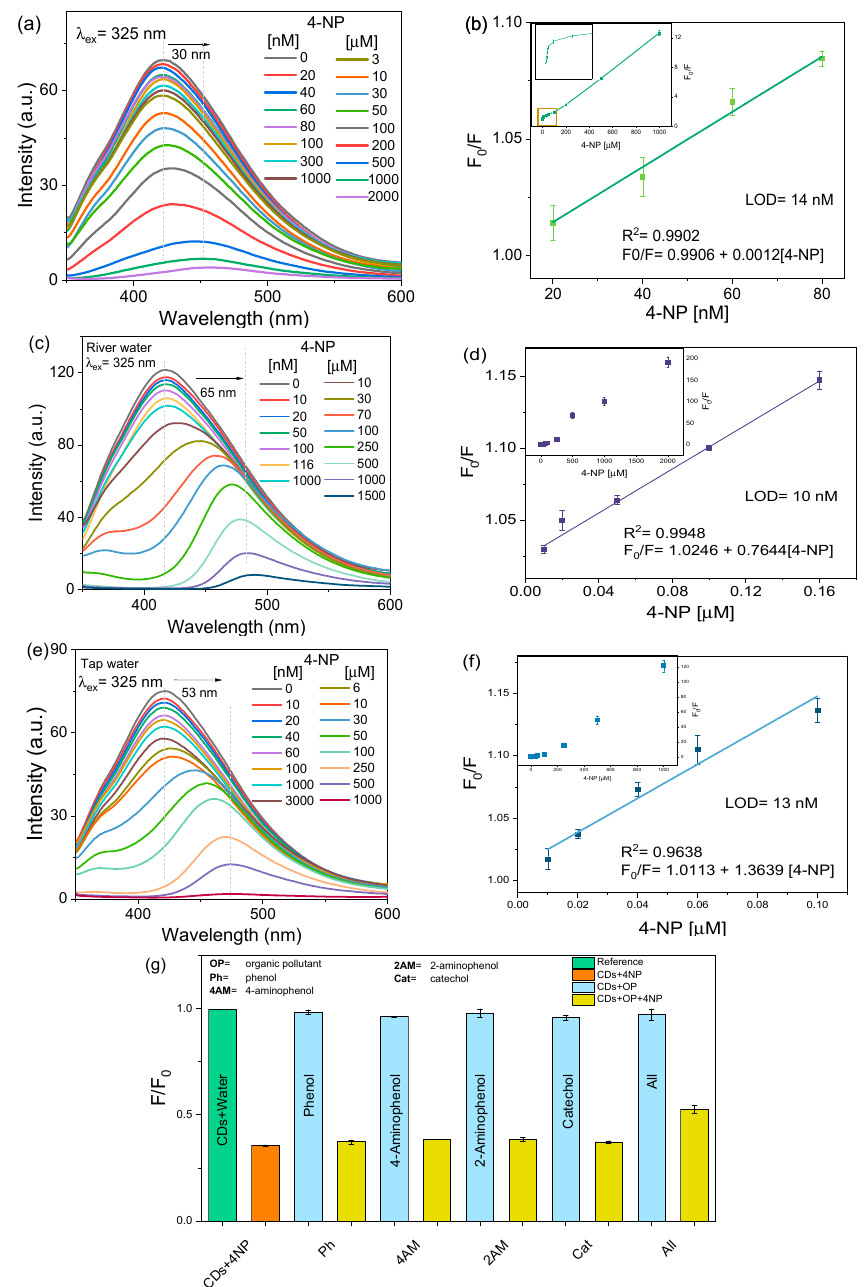
Figure 3a includes the sensitivity experiment of CDs towards 4-NP from 20 nm to 2 mM LCR of 4-NP in DI water with a PL turn-off effect, along with a spectral redshift (maximum wavelength signal shifted by 30 nm).